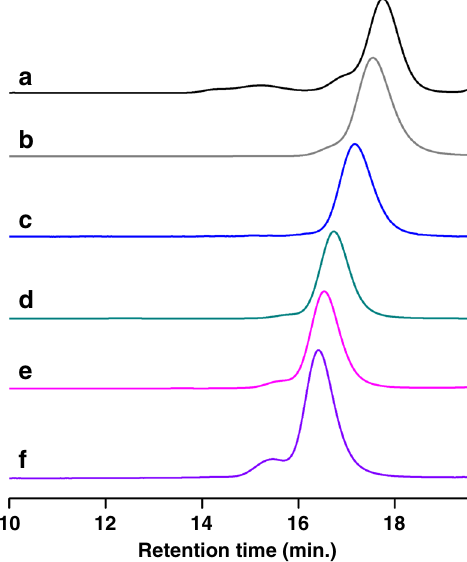
Fig. 3 Representative GPC traces of PGA samples from Table 1. a – f Correspond to the GPC traces of the PGA samples of entries 1, 3, 8, 11, 13, and 14, respectively